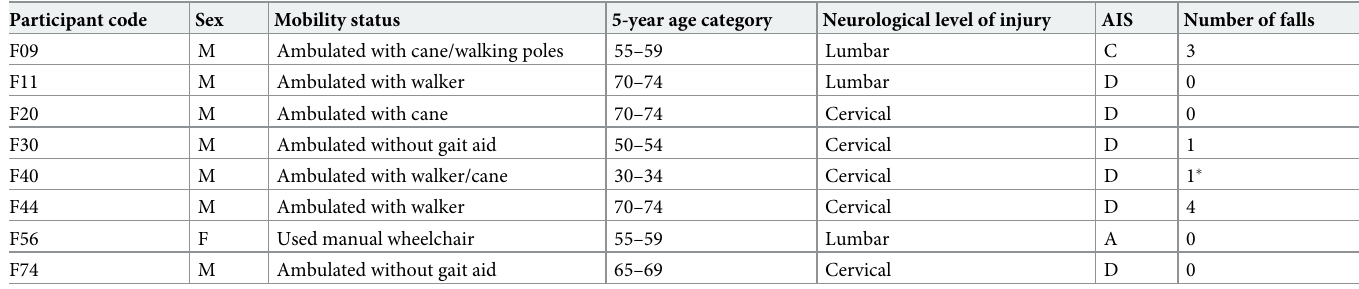
Table 1. Participant